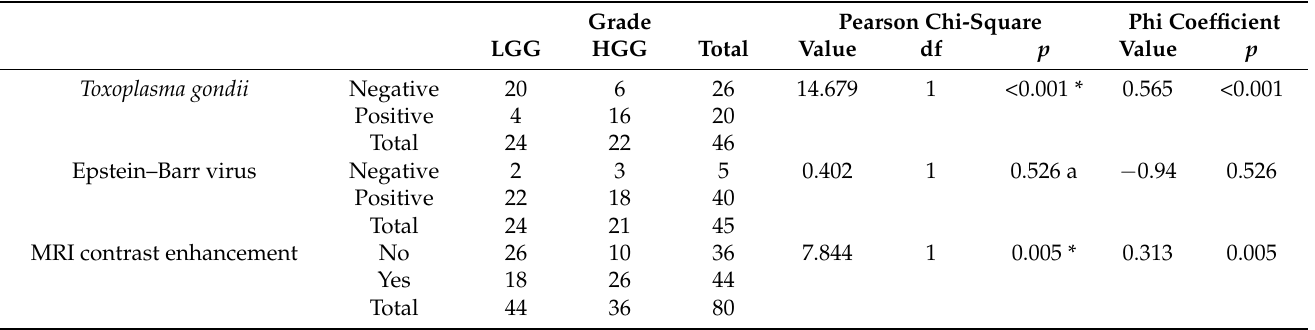
Table 4. The relationship between the WHO grade, serum antibody status, and MRI contrast enhancement. Grade